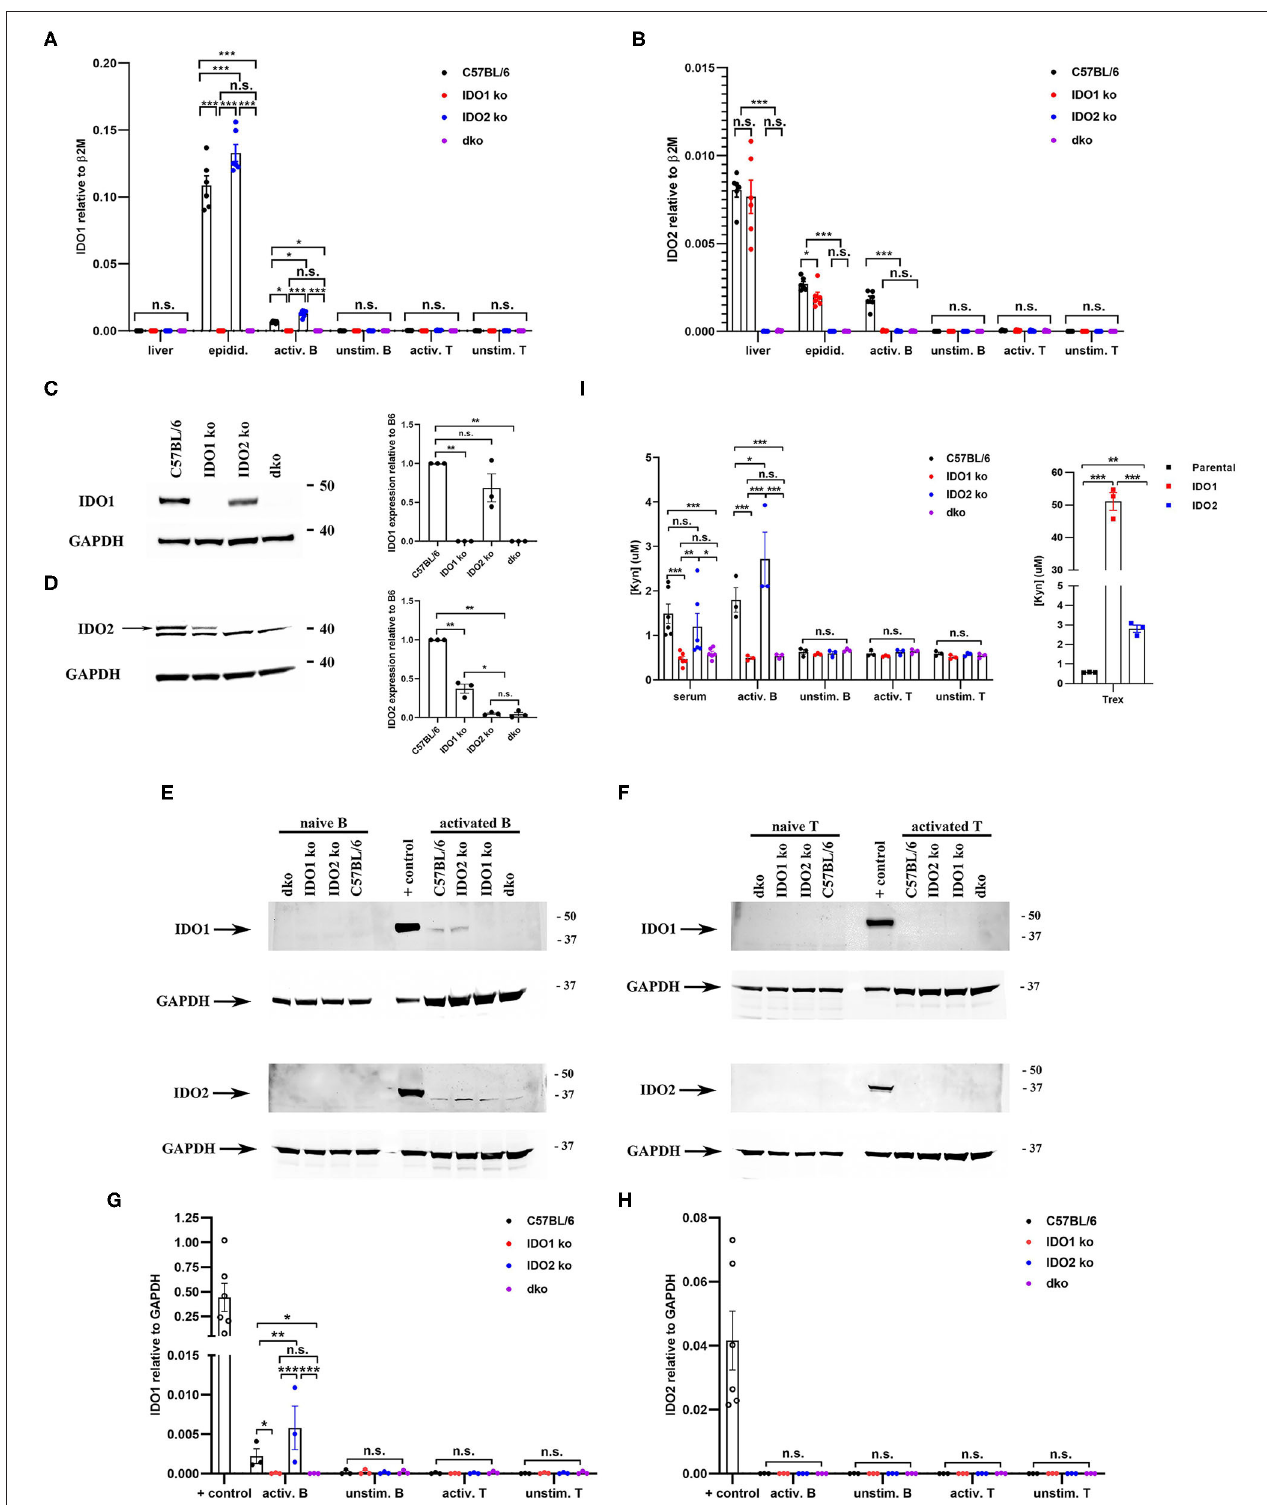
FIGURE 1 | Differential expression of IDO1 and IDO2 in knockout mice. Purified B and T cells were cultured for 48h either unstimulated (unstim.) or activated (activ.) with LPS + IL-4 (B cells) or anti-CD3 + anti-CD28 (T cells). (A) IDO1 and (B) IDO2 mRNA expression in liver, epididymis, and unstimulated/activated B and T cells isolated from C57BL/6, IDO1 ko, IDO2 ko, and dko mice was measured by qRT-PCR. Symbols represent individual pools of 3 mice and histograms show the